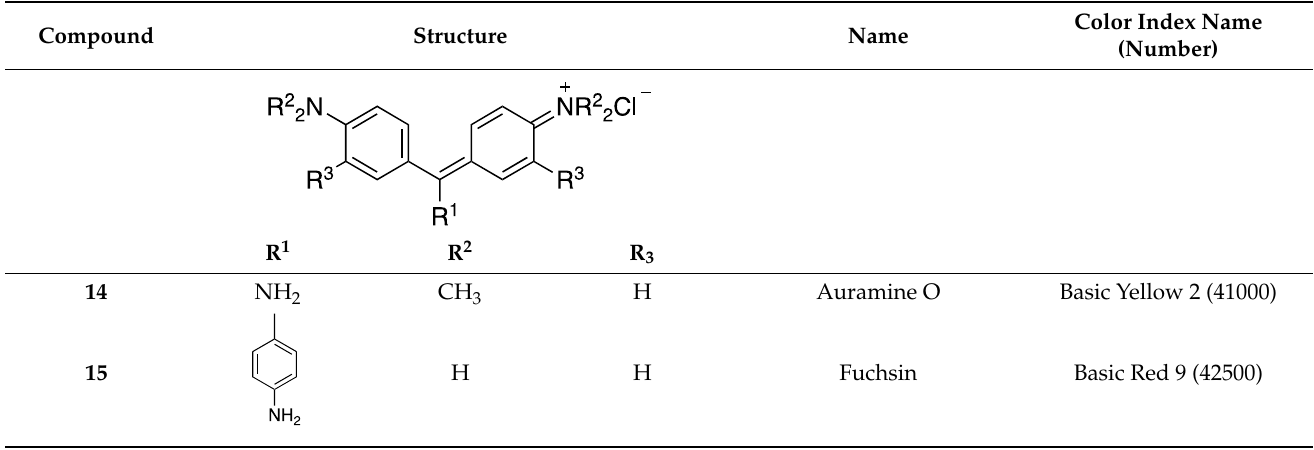
Table 3. Arylmethane textile dyes.